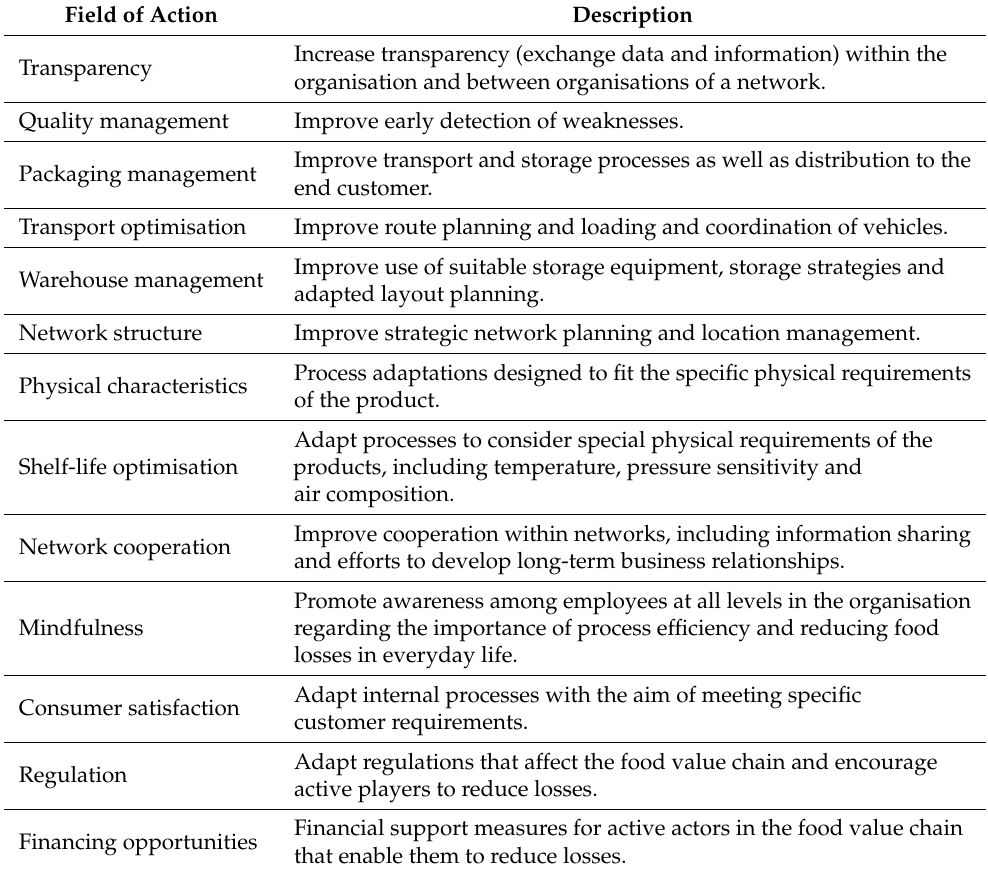
Table 1. Description of the food loss management fields of action